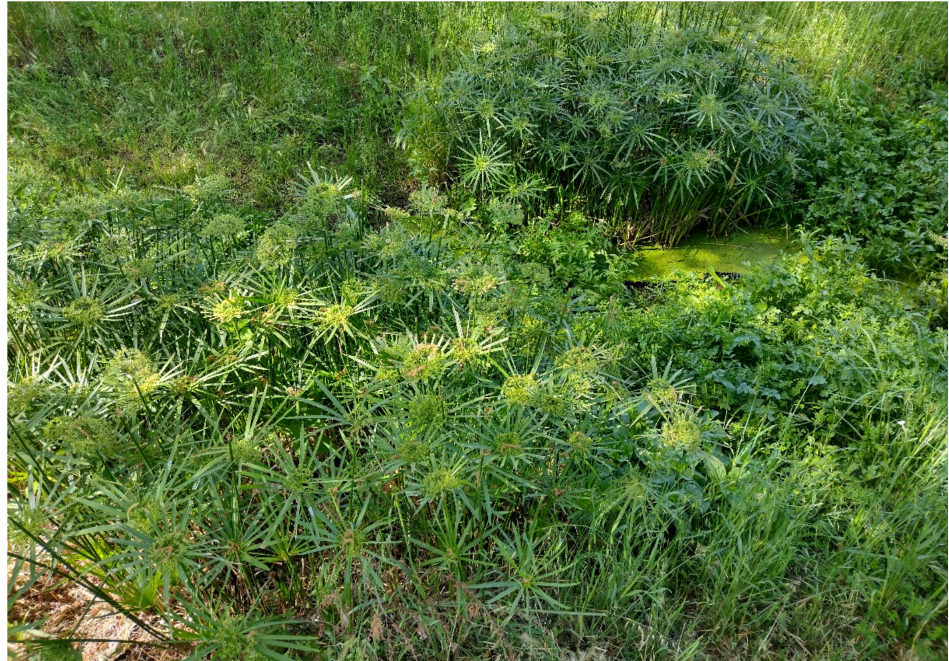
Figure 53. Cyperus alternifolius subsp. flabelliforme along channel Acqua Mariana as part of holophyte community of Phragmito-Magnocaricetea (Acquedotti